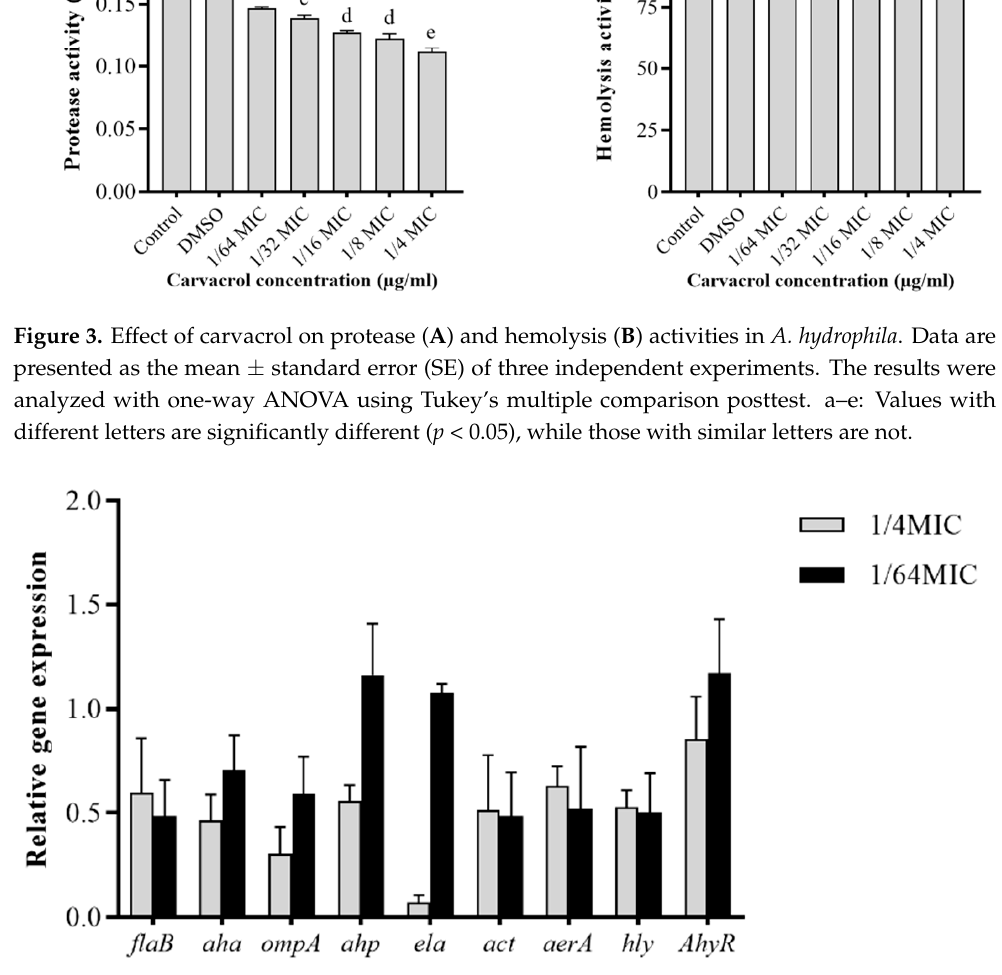
Figure 4. Effect of carvacrol on the virulence gene expression in A. hydrophila. Data are shown as the value of the carvacrol treated (1/4 MIC, 1/64 MIC) group divided by that of the DMSO (negative control) group. Data are presented as the mean ± standard error (SE) of three independent experi- ments.